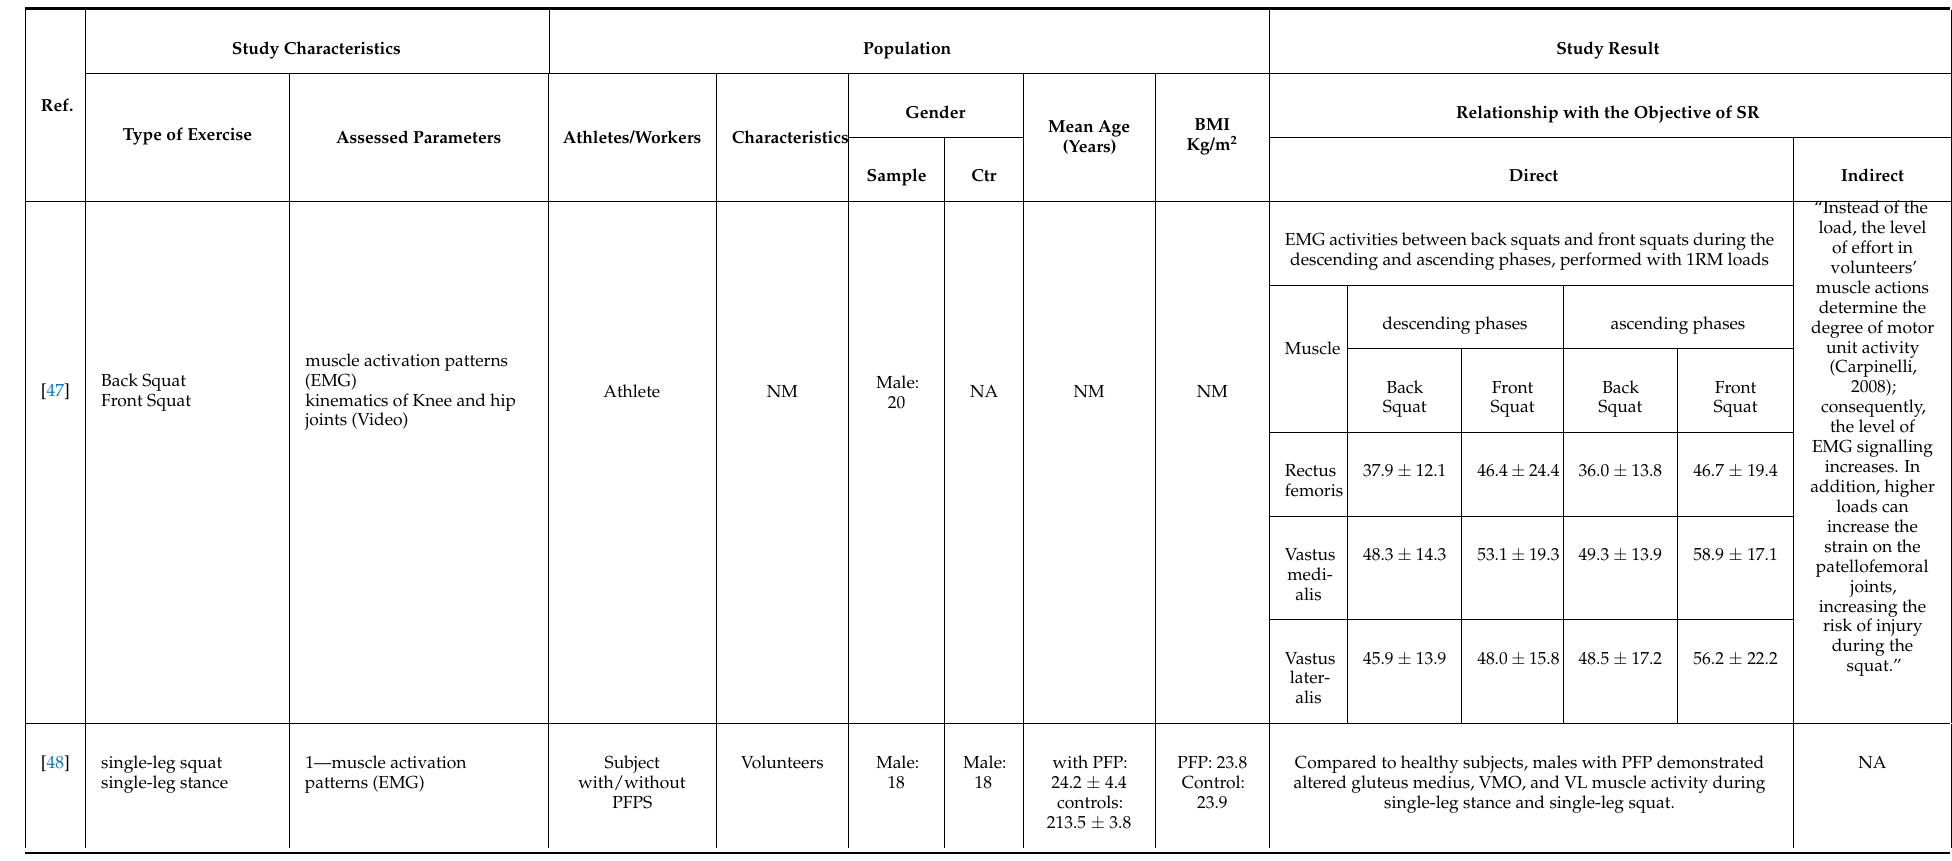
Compared to healthy subjects, males with PFP demonstrated altered gluteus medius, VMO, and VL muscle activity during single-leg stance and single-leg